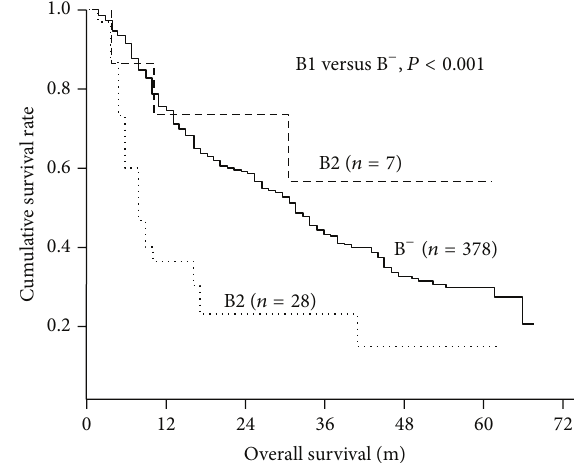
Figure 2: Kaplan-Meier curves of overall survival of the 35 patients with bile duct invasion according to different type of bile duct invasion. B1, central type; B2, peripheral